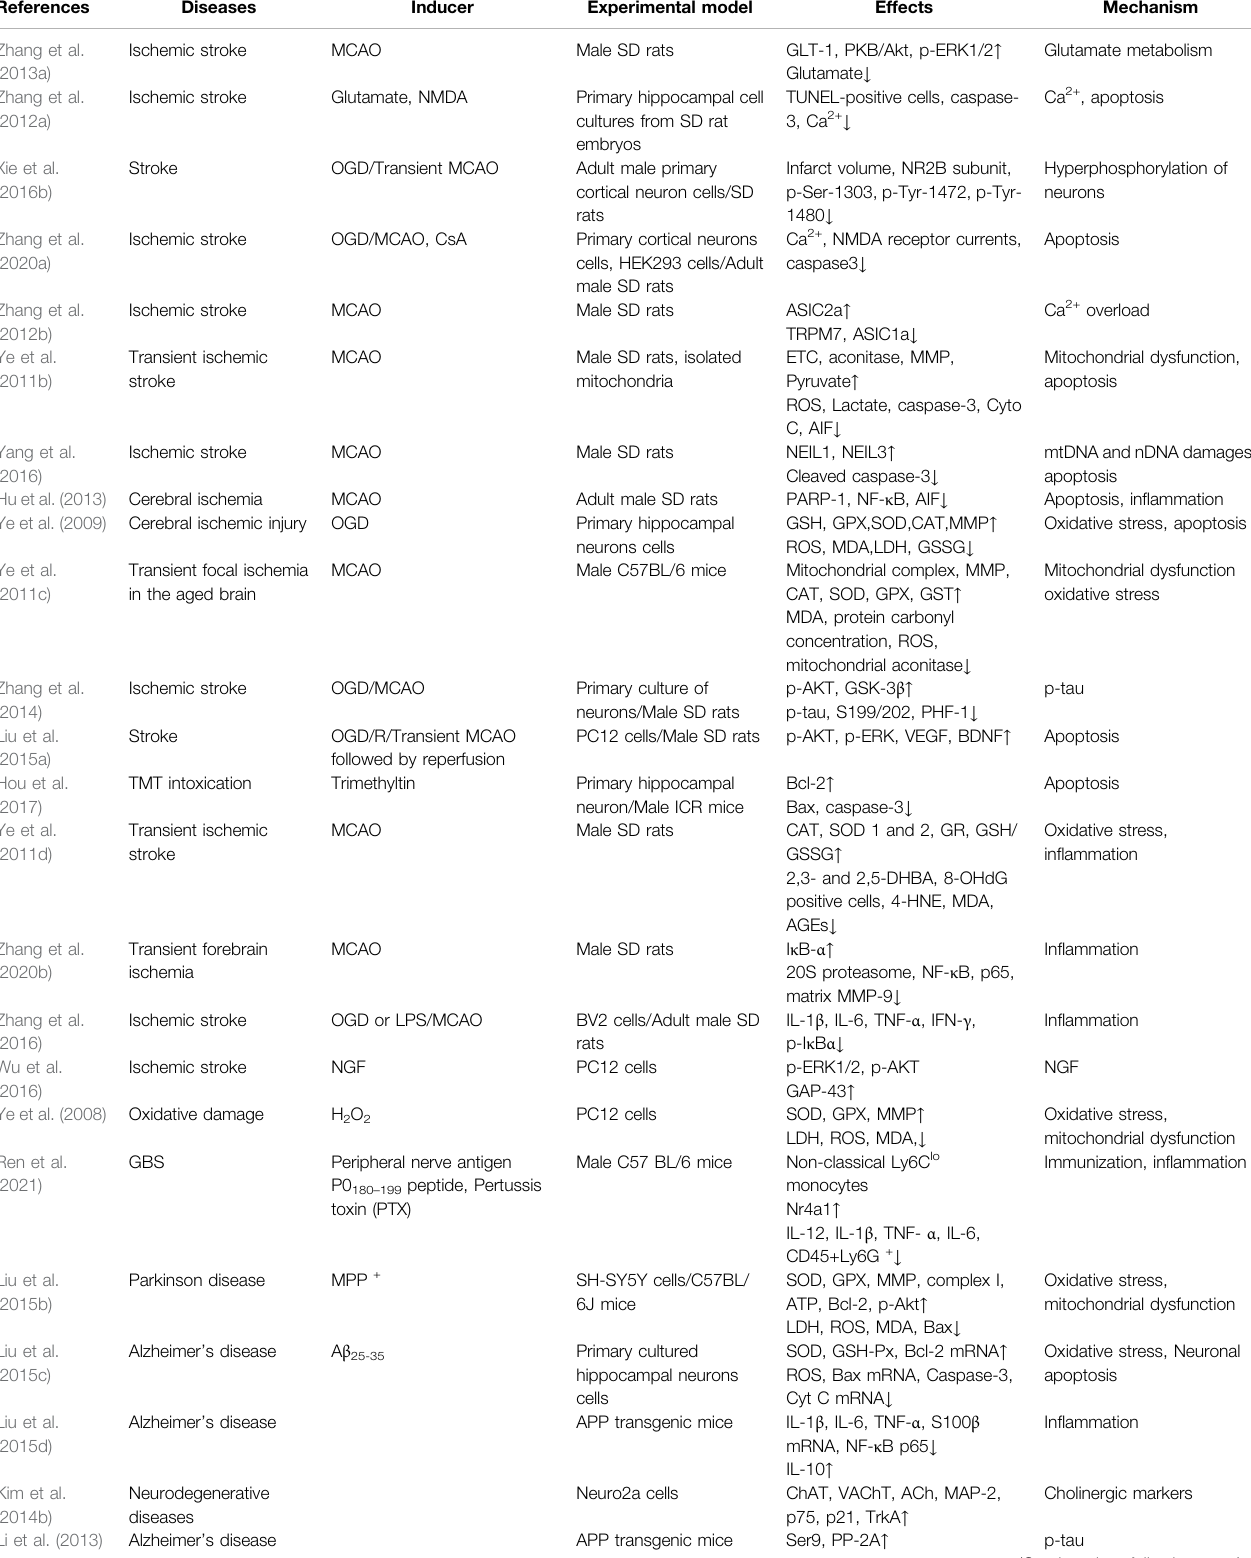
TABLE 2 | Summary of the neuroprotective effects and mechanism of ginsenoside Rd in animal and cell